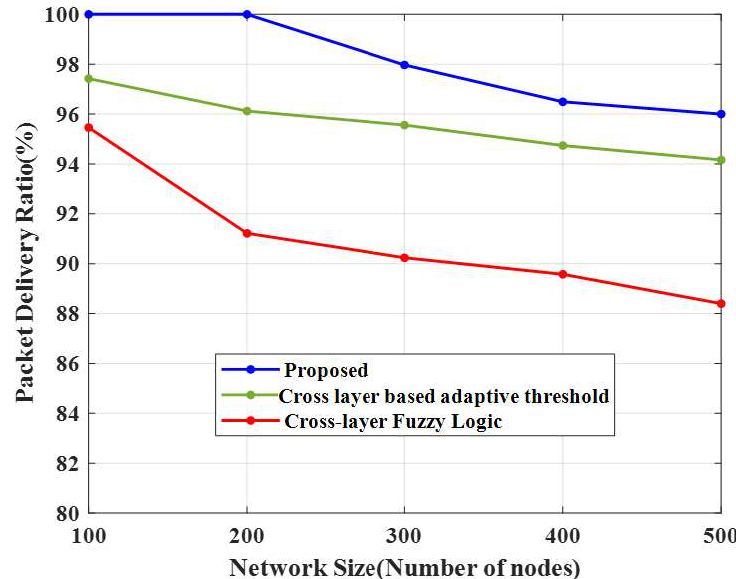
Figure 9. Comparison of the packet delivery ratio.